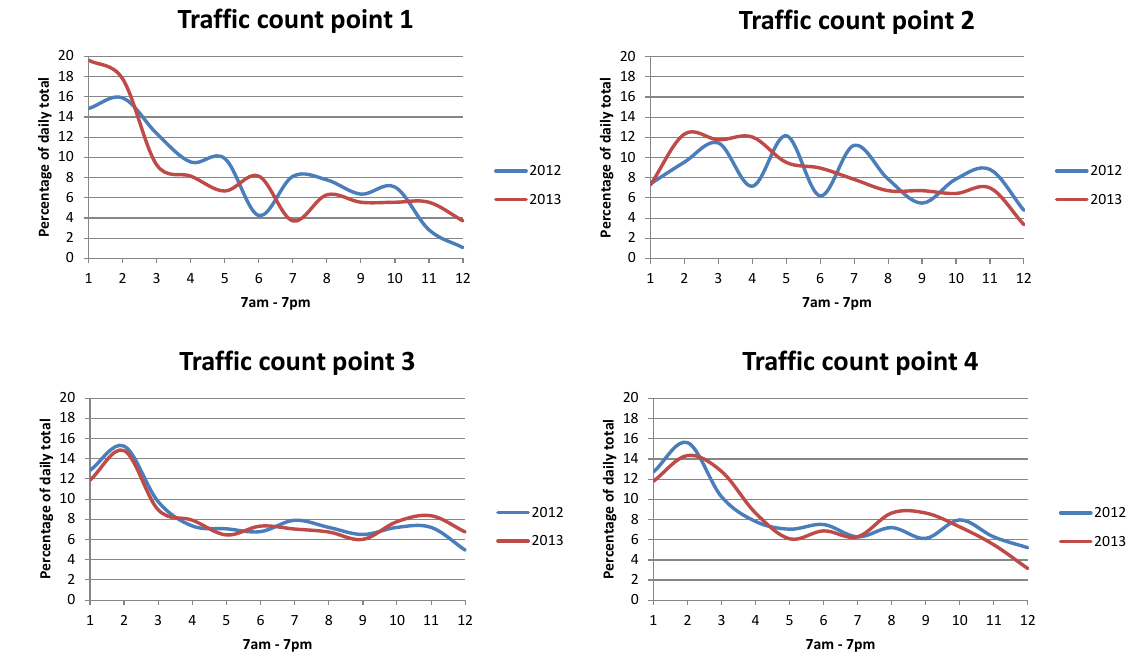
Figure 3. Hourly distribution of all traffic entering the University on